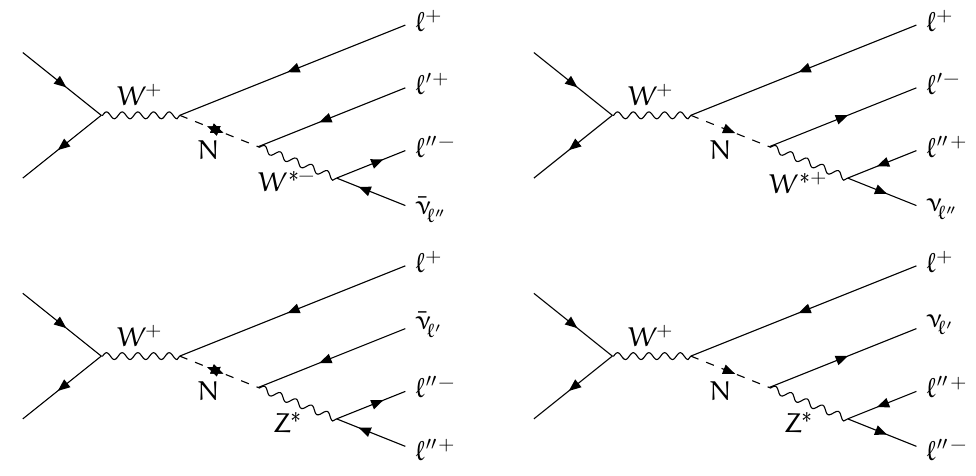
Figure 1 . Typical diagrams for the production and decay of an HNL through its mixing with an SM neutrino, leading to final states with three charged leptons and a neutrino. The HNL decay is mediated by either a W ∗ (upper row) or a Z ∗ (lower row) boson. In the diagrams on the left, the HNL is assumed to be a Majorana neutrino, thus ‘ and ‘ 0 in the W ∗ -mediated diagram can have the same electric charge, and lepton number can be violated. In the diagrams on the right, the HNL decay conserves lepton number and can be either a Majorana or a Dirac particle, and, therefore, ‘ and ‘ 0 in the W ∗ -mediated diagram have always opposite charge. The present study considers only the case where ‘ and ‘ 0 (or n ), and in case of the decay mediated by a Z ∗ boson ‘ 0 also ‘ 00 , are of the same